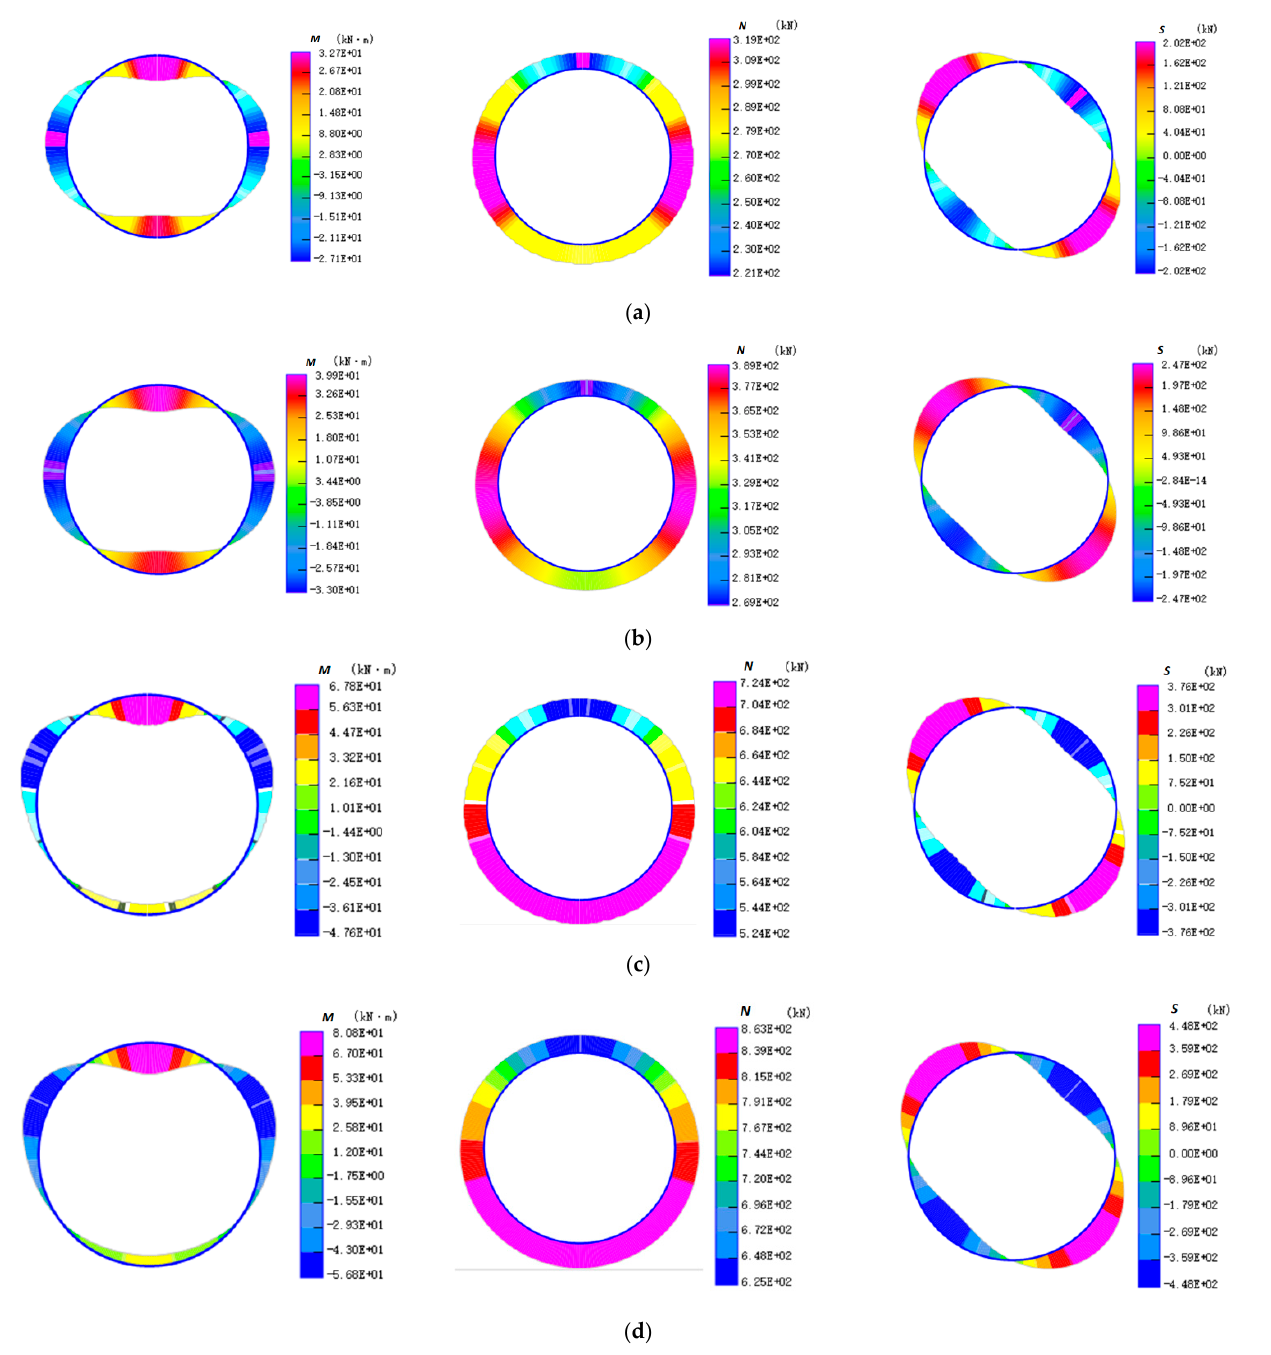
Figure 10. Calculation results of lining ring structure (The letter E stands for multiplying by the n th power of 10; M —bending moment; N —Axial force; S —Shearing force). ( a ) Modified routine method result (outer diameter 4.1 m, thickness 0.25 m). ( b ) Beam–spring method result (outer diameter 4.1 m, thickness 0.25 m). ( c ) Modified routine method result (outer diameter 8.2 m, thickness 0.4 m). ( d ) Beam–spring method result (outer diameter 8.2 m, thickness 0.4 m).